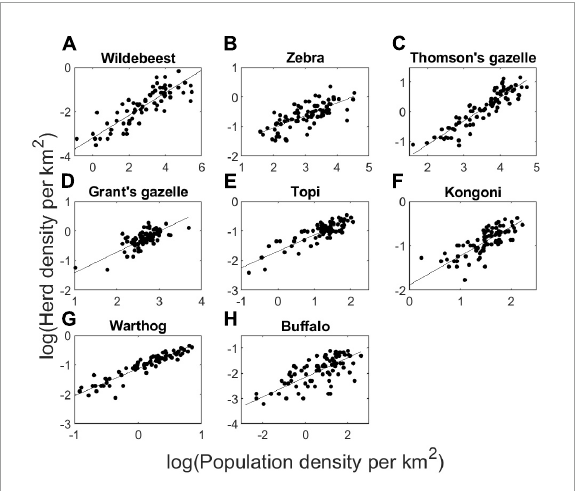
FIGURE1 Log-transformed herd density plotted against log-transformed population density of 8 species of large herbivores in Serengeti National Park recorded during 80 monthly censuses conducted during 2005–2012. Best-fit regression lines provide the parameter values of ε and β of the power function ( H = ε N β ) applied to the functional response model (Eq. 2). Panels correspond to wildebeest (A) , zebra (B) , Thomson’s gazelles (C) , Grant’s gazelles (D) , topi (E) , hartebeest (F) , warthog (G) , and buffalo (H)